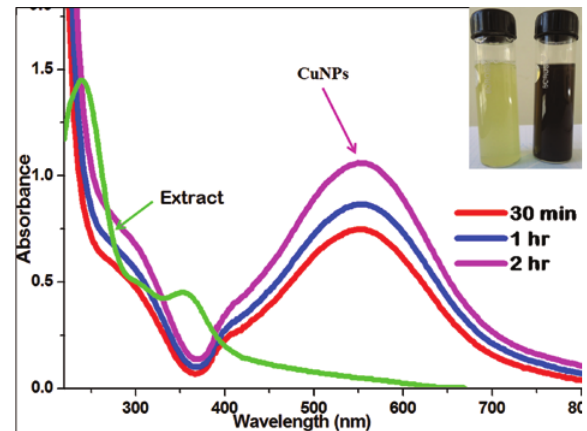
Figure 1: UV-visible spectra of D. erecta fruit extract and synthesized CuNPs (inset shows the change in color after the formation of CuNPs).